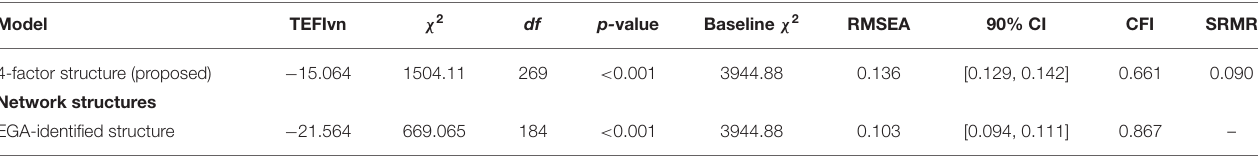
The parameters (factor loadings and factor correlations) of all factor models are displayed in Supplementary Tables 11–38